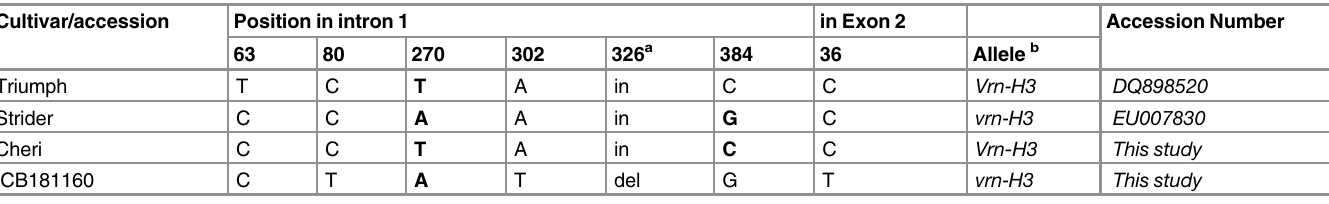
Table 4. Barley haplotype scoring from six SNPs and one indel in the intron 1 and exon 2 of Vrn-H3 gene.